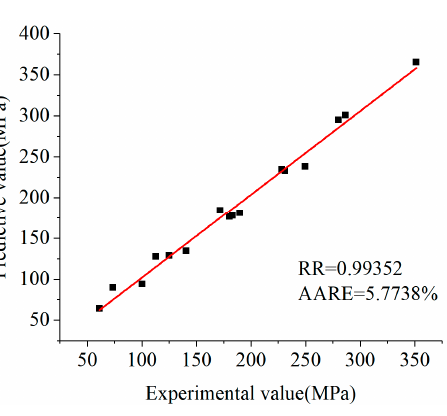
Figure 7. The correlation between experimental stress and predicted stress of the peak stress of 21-4N heat-resistant steel.